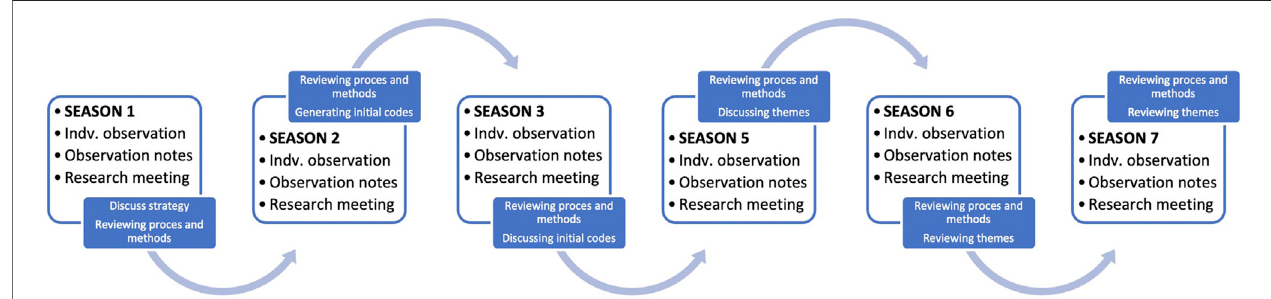
FIGURE 1 | Overview of